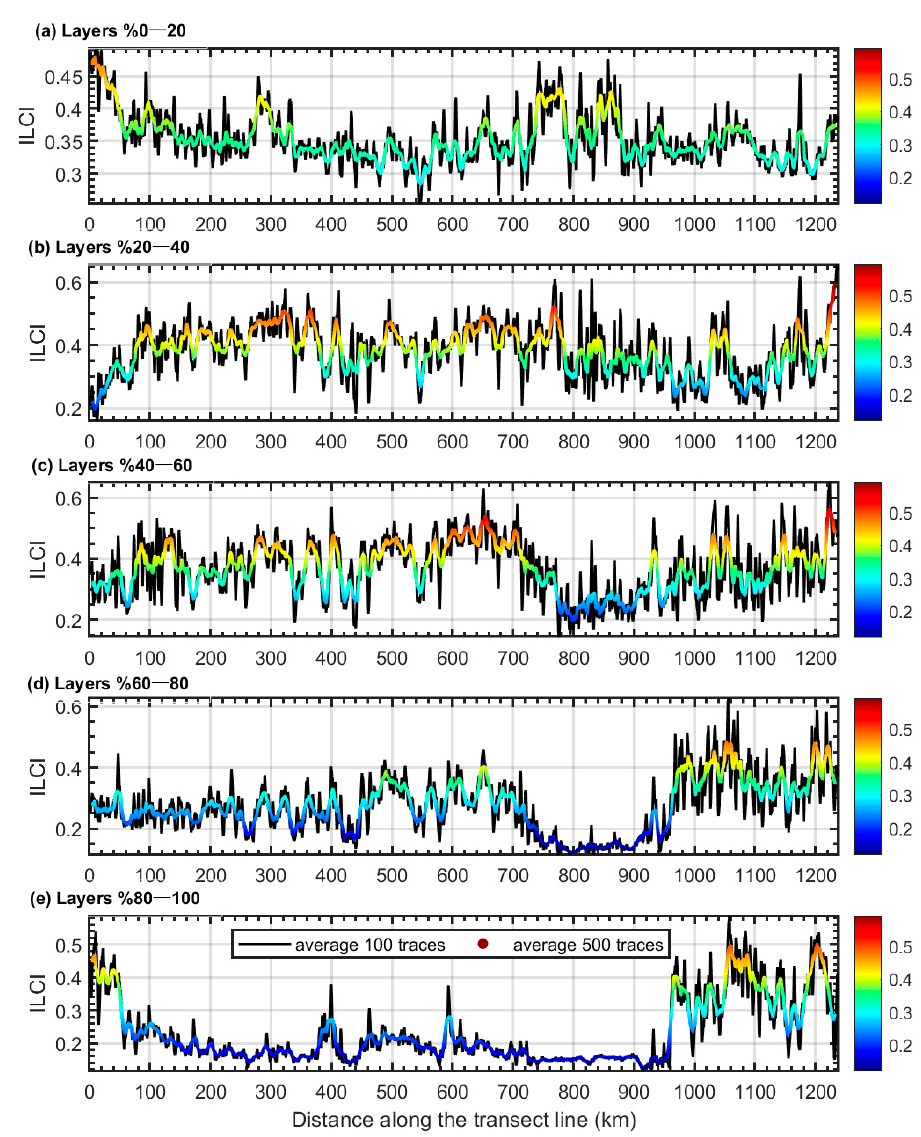
Figure 7. ILCI graphs of depth range derived from airborne radar profile from Zhongshan Station to Dome A. ( a – e ) show the ILCI results for each fifth ice depth.